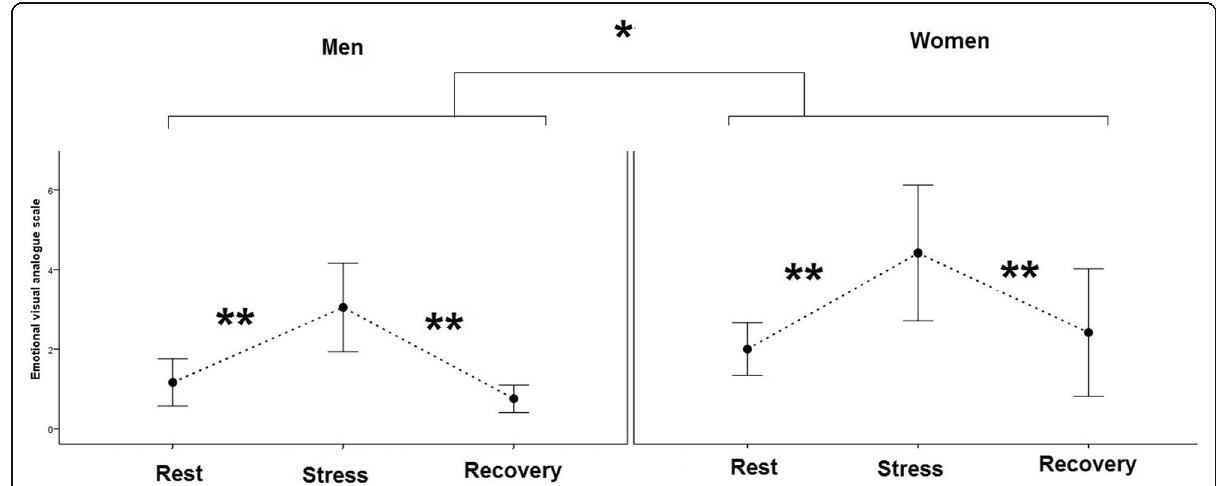
Fig. 2 The plot shows the mean and CI 95% of emotional visual analog scale in the men and women in the rest, stress, and recovery condition. * p < 0.05, ** p <